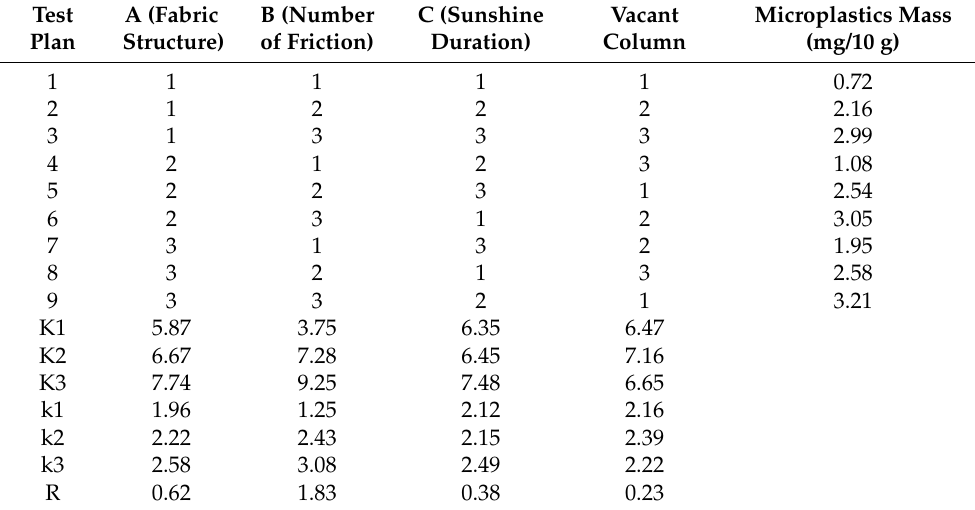
Table 9. Test results and visual